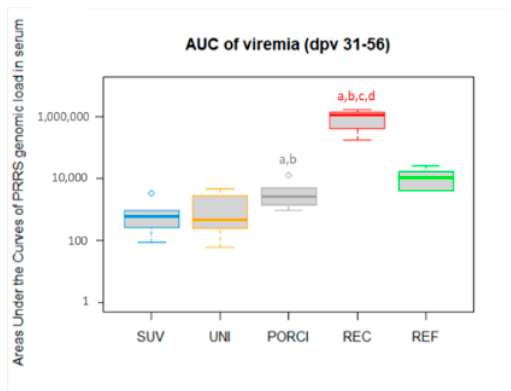
Figure 4. The individual areas under the curves (AUC) of viral loads quantified in serum from dpv 31 to 56 (post-challenge period). The SUV, UNI and PORCI groups were vaccinated with the vaccines Suvaxyn, Unistrain or Porcilis PRRS at day 0, and challenged at dpv 28. The REC and